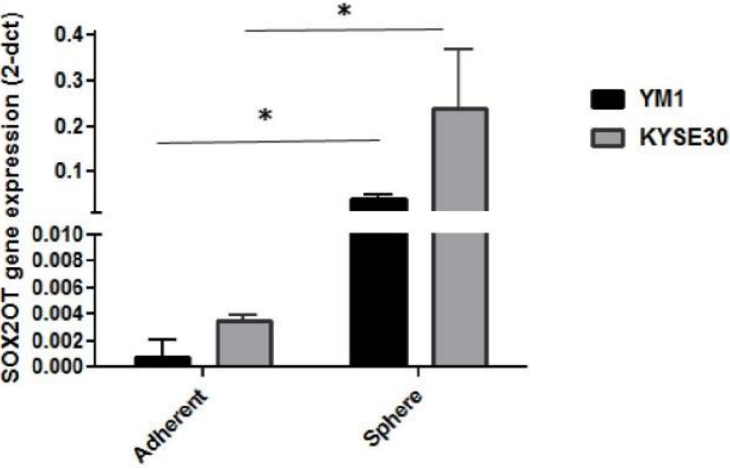
Figure 3. Overexpression of SOX2OT in tumorspheres of esophageal cancer cells (YM1 and KYSE30) * p -value < 0.05. bars represent mean ± SE.